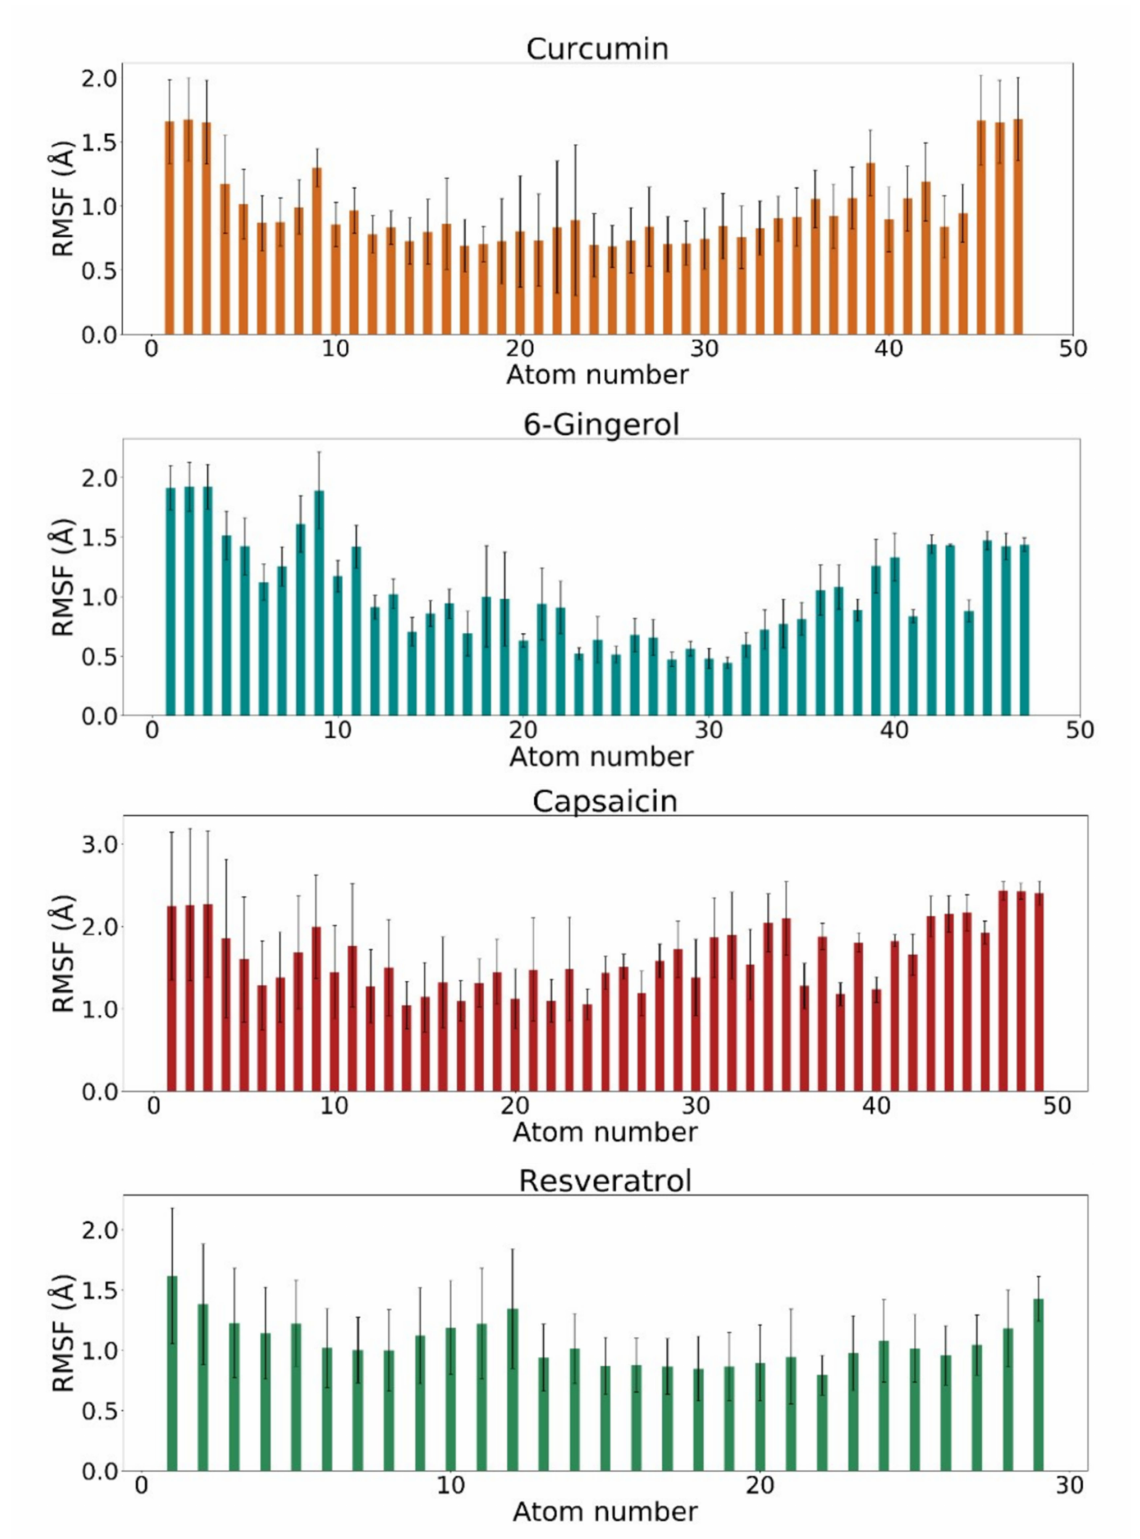
Figure 4. Root mean square fluctuation (RMSF) values of ligand atomic positions throughout molecular dynamics simulation production runs of four investigated systems: curcumin in complex with PDE4D (orange), 6-gingerol in complex with PDE4D (blue), capsaicin in complex with PDE4D (red), and resveratrol in complex with PDE4D (green). The atom numbers correspond to ligand numbering presented in Figure 1. Error bars indicate standard deviations between four independent MD